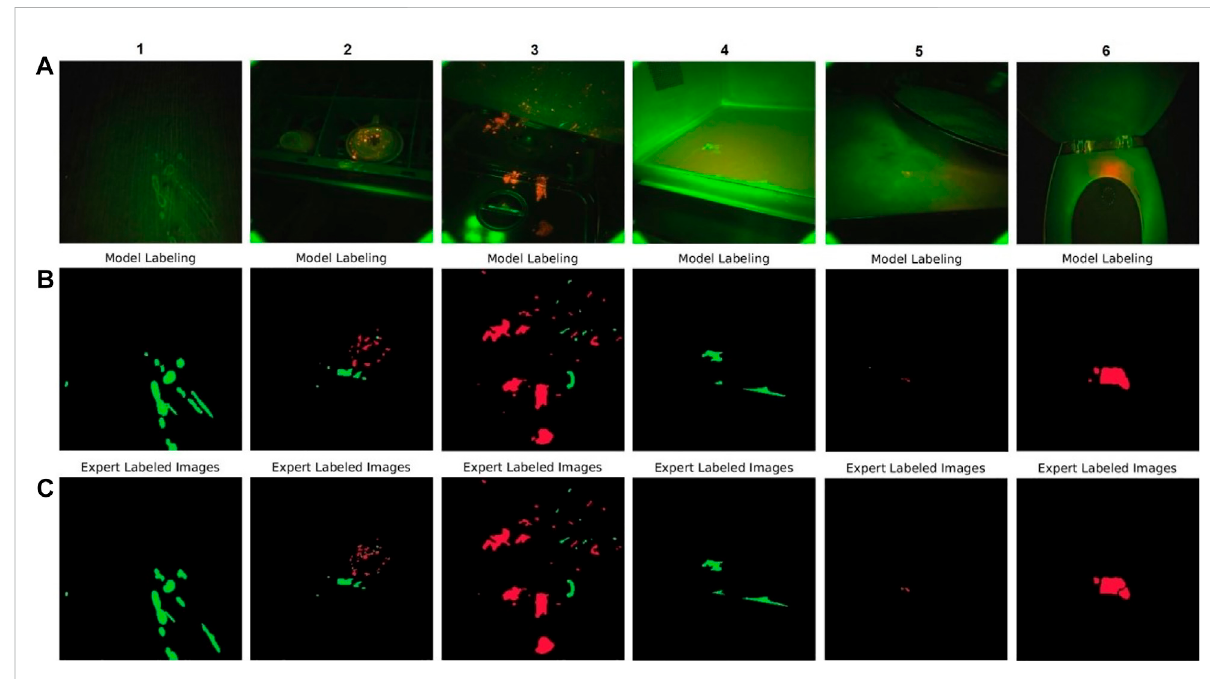
FIGURE 6 DeepLabv3+modelperformanceonselectedtestsetvideoframes (A) CSI-D fl uorescenceimageframesinputtoDeepLabv3+. (B) DeepLabv3+ segmented image output. (C) Same images segmented and labeled by human